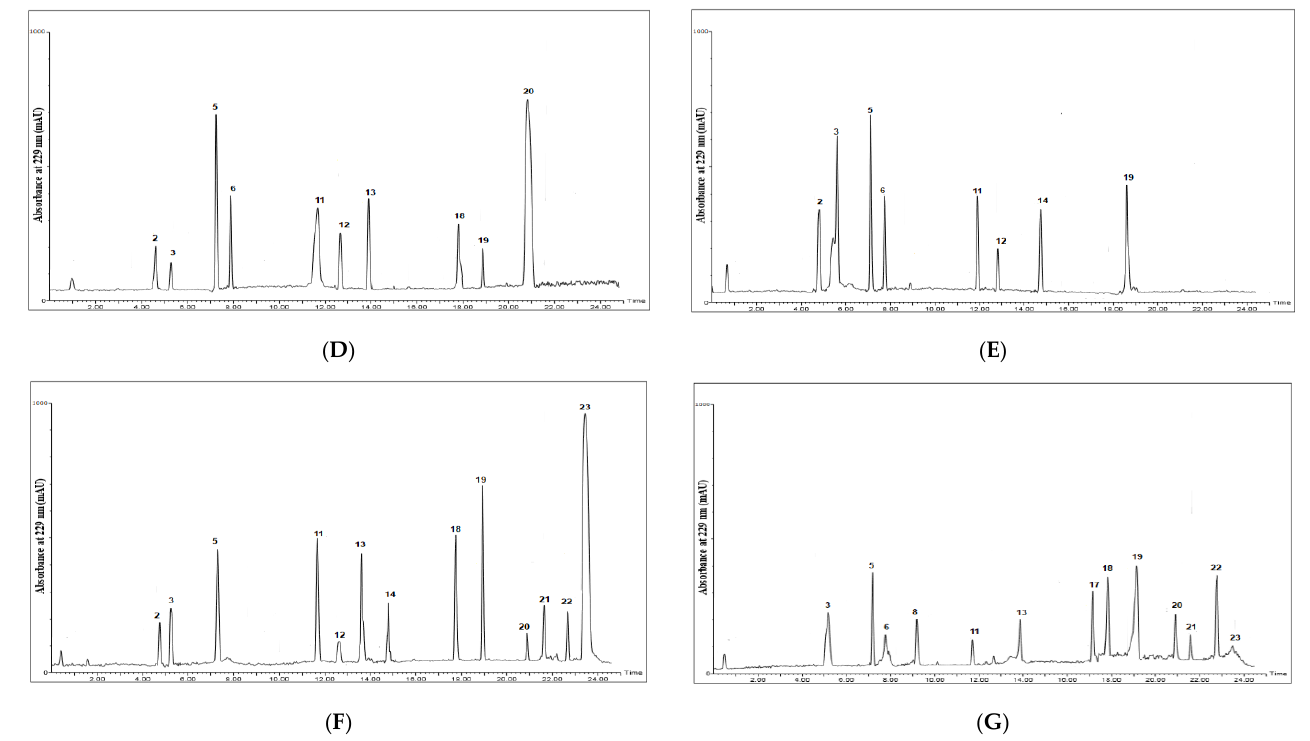
Figure 2. Chromatograms of desulfoglucosinolates in the standard glucosinolate mixture ( A ) and the alcoholic extracts of the tested seeds. ( B ) Raphanus raphanistrum L. ( C ) Raphanus sativus L. ( D ) Brassica oleracea var. botrytis L. ( E ) Brassica oleracea var. capitata L. ( F ) Brassica rapa L. ( G ) Eruca sativa L. Numbers on charts indicate names of corresponding glucosinolates, which are given.